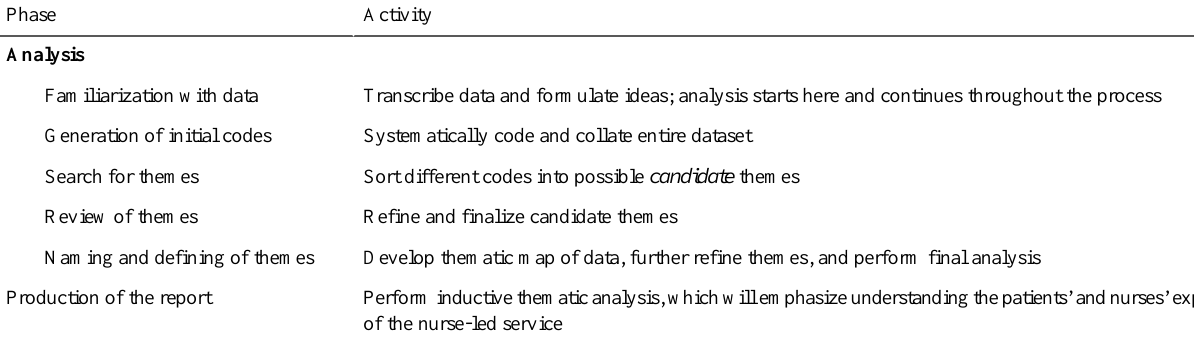
Table 4. Process of thematic analysis, adapted from Braun and Clarke